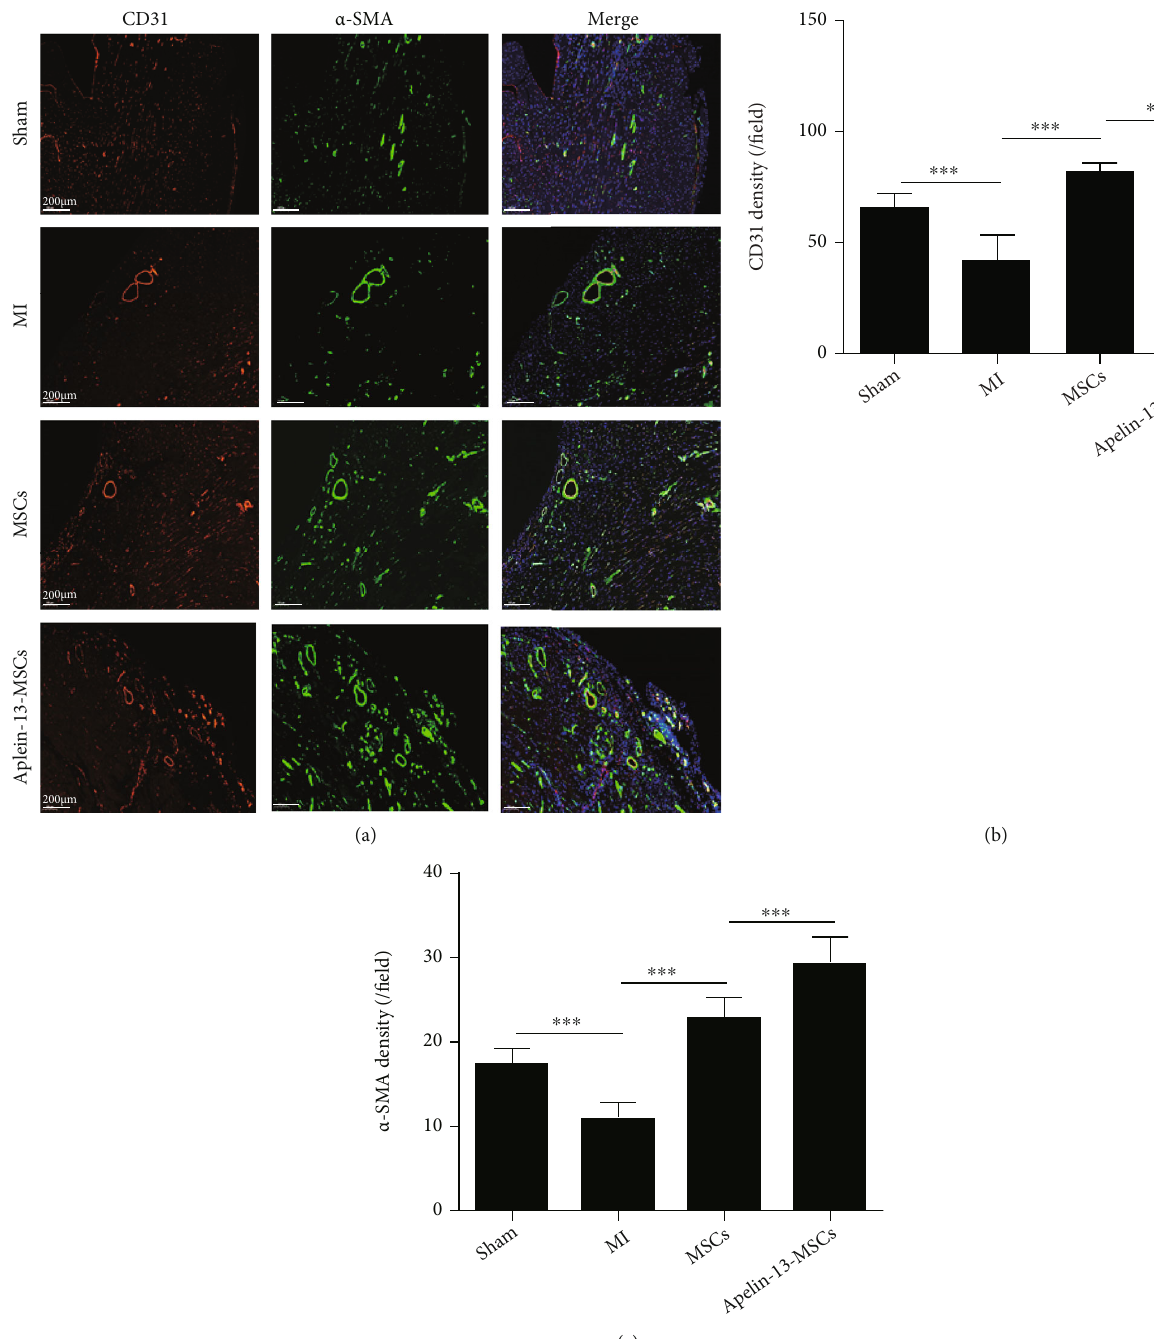
Figure 6: Transplantation of Apelin-13-pretreated MSCs improves angiogenesis in mouse hearts following infarction. (a) Representative images of CD31 staining and α -SMA staining in the ischemic heart of mice at 4 weeks among the di ff erent groups. (b) Quantitative analysis of the capillary density in the ischemic heart at 4 weeks among the di ff erent groups. (c) Quantitative analysis of the arteriole density in the ischemic heart at 4 weeks among the di ff erent groups. n = 6 mice for each group. Data are expressed as mean ± SD . ∗ p < 0 : 05 , ∗∗ p < 0 : 01 , ∗∗∗ p < 0 : 001